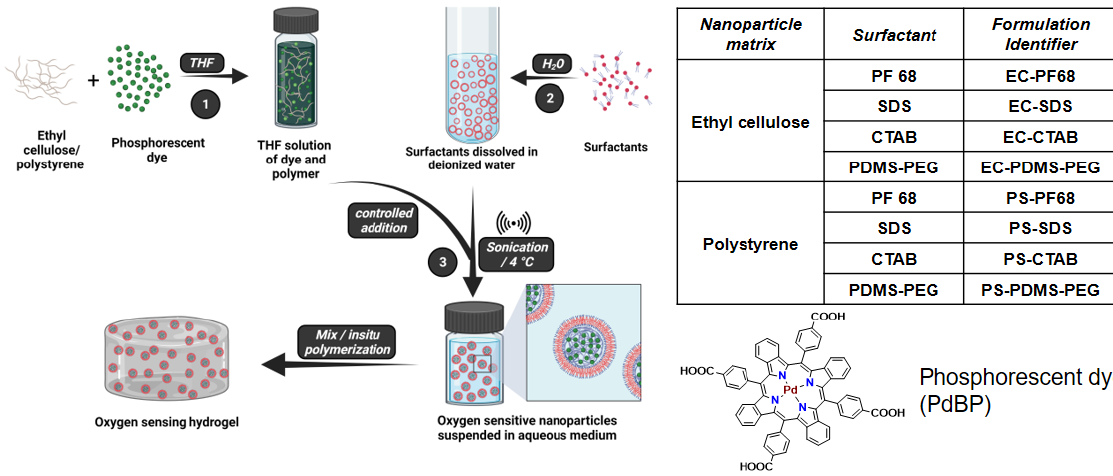
Figure 1. Synthesis of oxygen-sensing nanoparticles. Oxygen-sensitive phosphorescent dye and polymer (ethyl cellulose or polystyrene) are dissolved in tetrahydrofuran (THF). This solution is then mixed with the surfactant solution in deionized water (containing the micelles) during sonication. Nanoparticles were obtained after removal of solvent by evaporation.